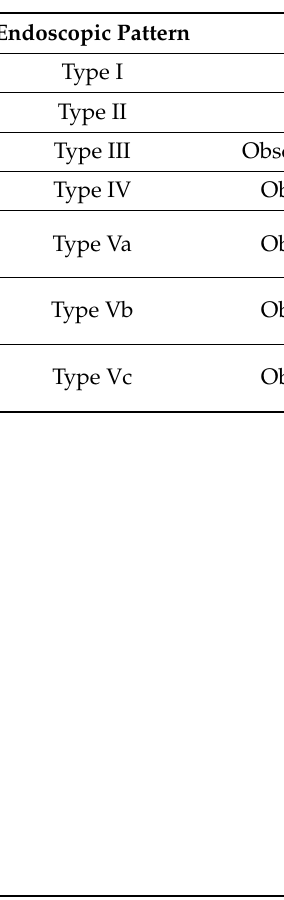
Table 1. Narrow-band imaging endoscopic classification of the laryngeal lesions according to Ni et al. (2011) [2].